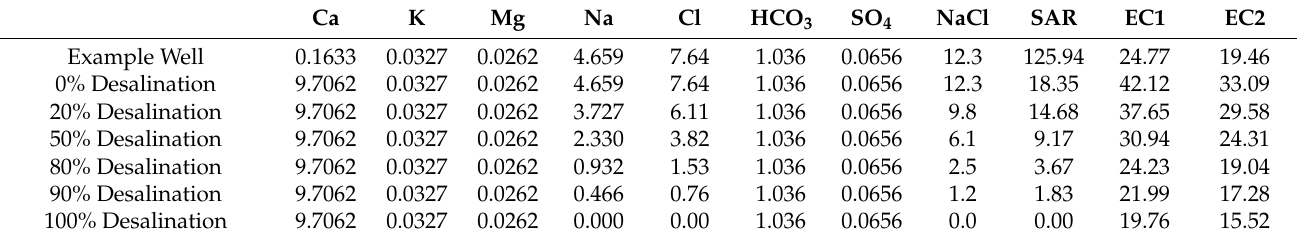
Table 4. Example flowback water composition from a shale gas well, USA (Marcellus Shale), where P w includes >5.6 g FeSO 4 L − 1 . All measurements are in g L − 1 . EC1 = EC, when F = 0.55; EC2 =